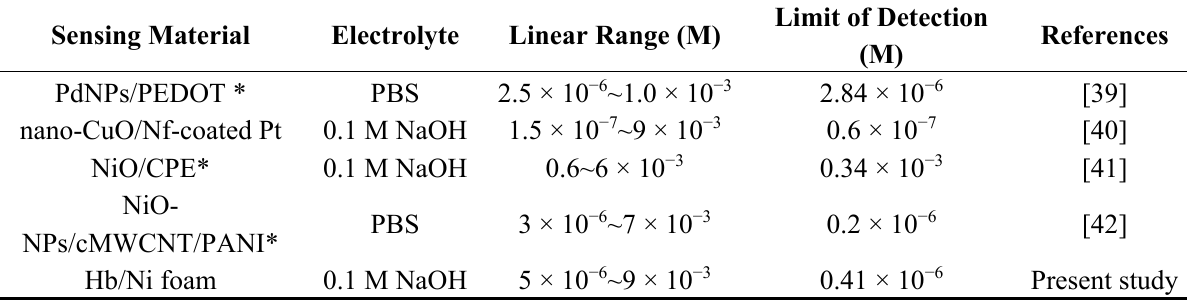
Table 2. Comparison of the Hb-modified Ni foam-based hydrogen peroxide sensor with other non-enzymatic hydrogen peroxide